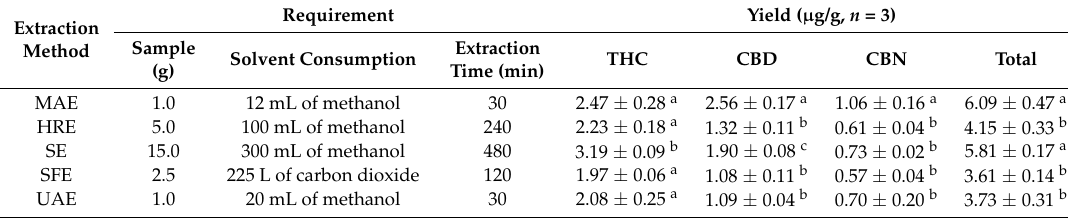
Table 4. Comparison of extraction yields for different extraction